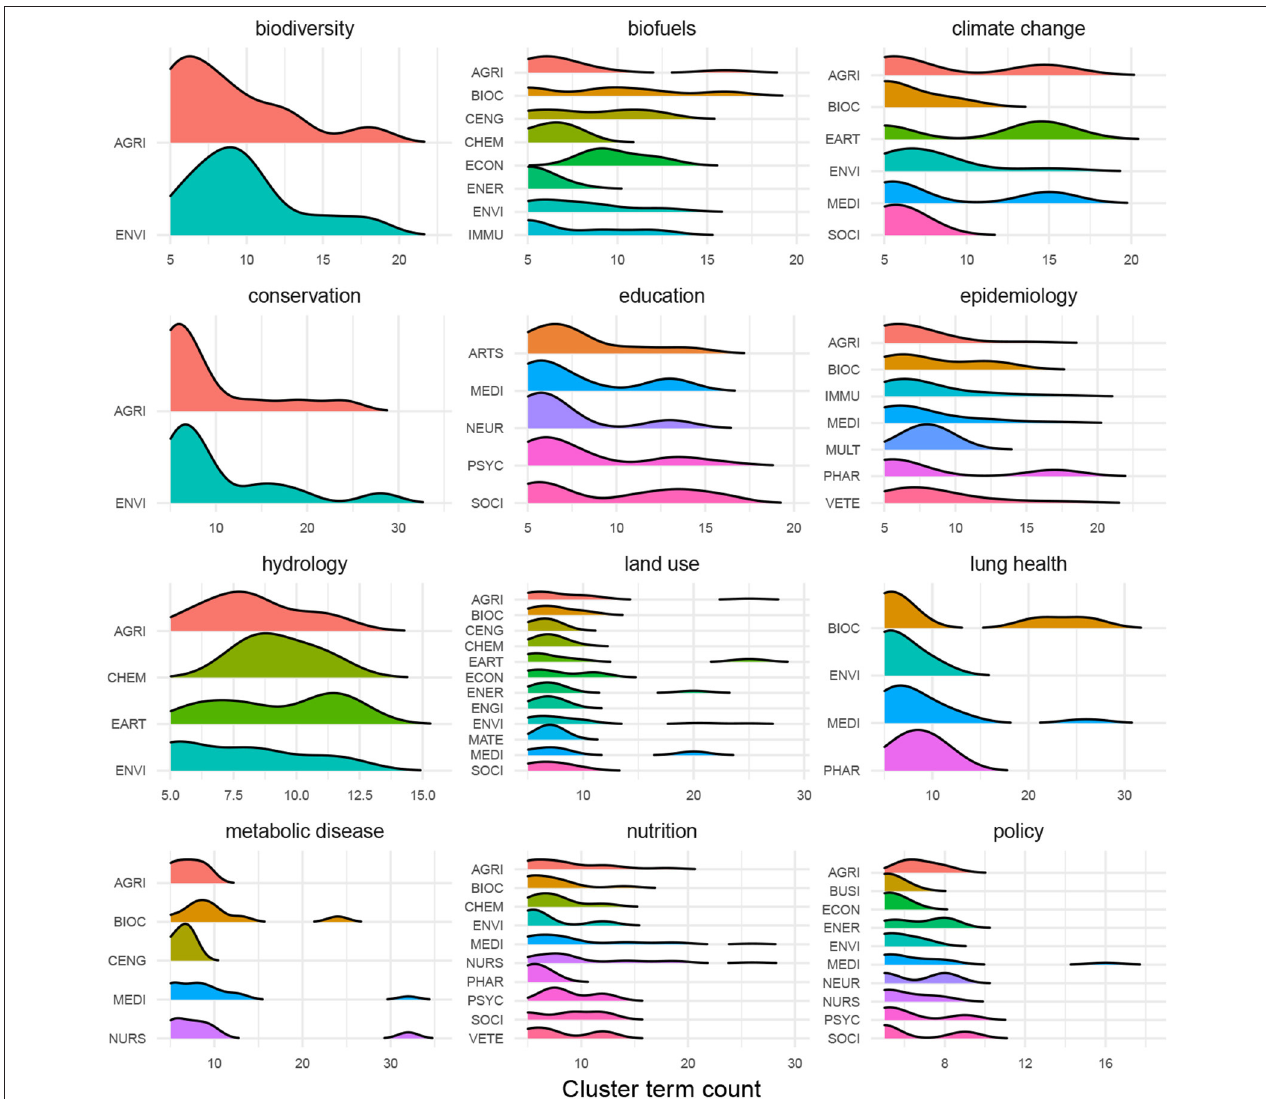
FIGURE 5 | Density distributions for selected cluster term counts by ASJC subject areas. Only papers with at least 5 terms from the given cluster are included; only subject areas with at least 3 papers satisfying this condition are included. Colors correspond to ASJC subject areas across panels. Curve heights relative to gray baselines are comparable within panels, but not between